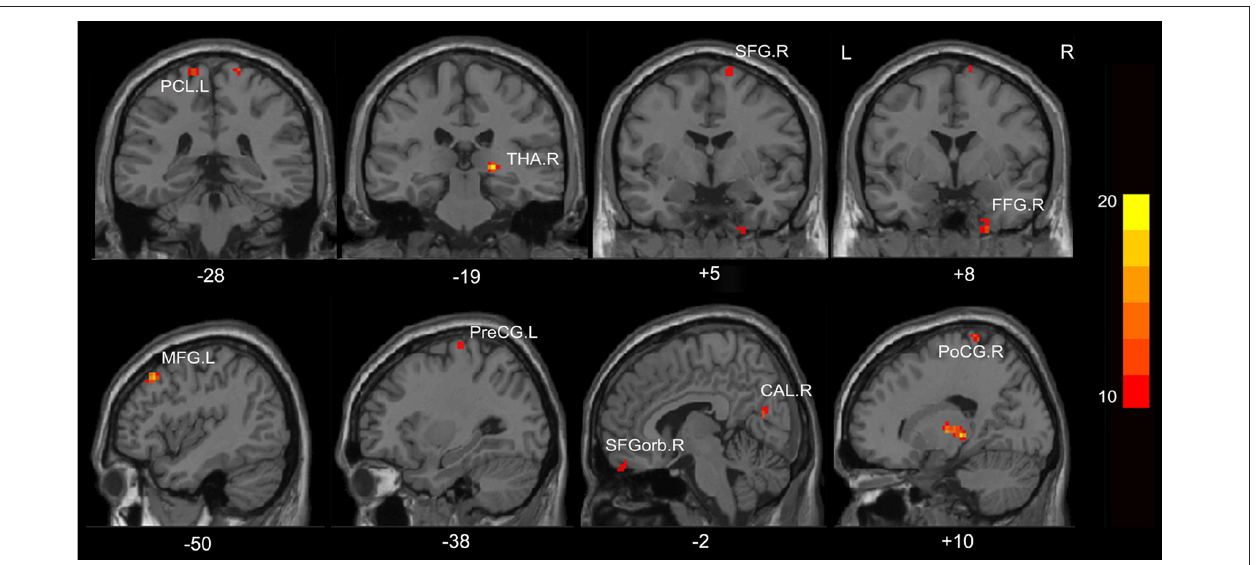
of low- frequency drifts and high-frequency physiological